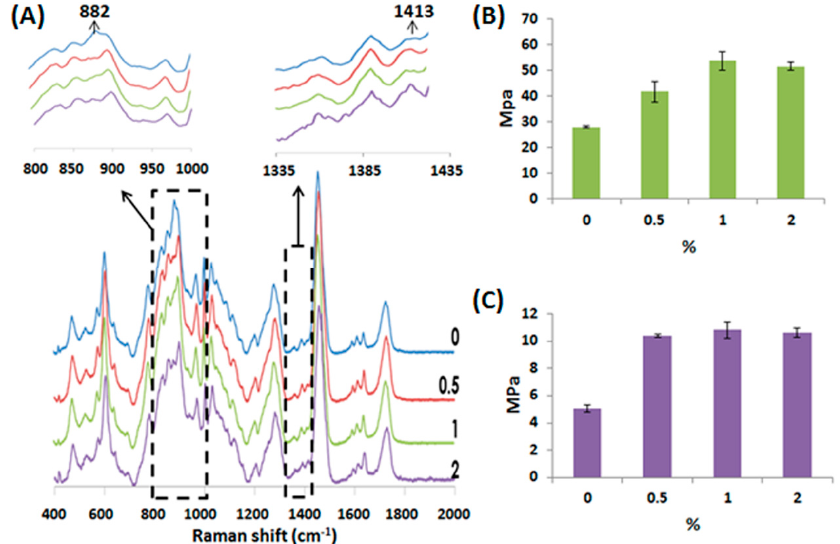
Figure 3. ( A ) Raman spectra of the PU/HA hybrid scaffolds with different hyaluronic acid (HA) concentration; The ( B ) Young’s modulus and ( C ) diametral tensile strength values of the PU/HA hybrid scaffolds.